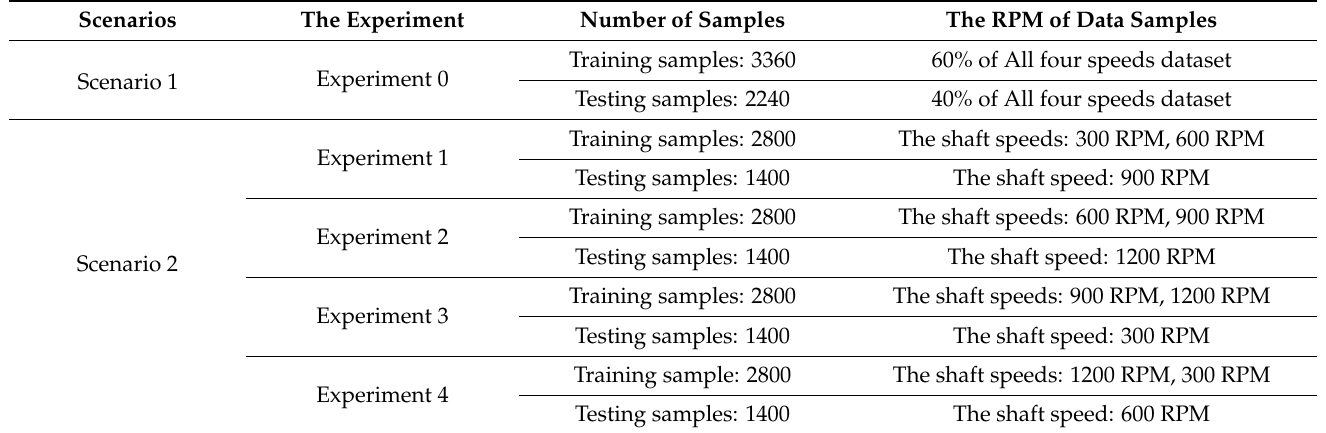
Table 4. Description of the dataset for training and testing with RPM in the experiment